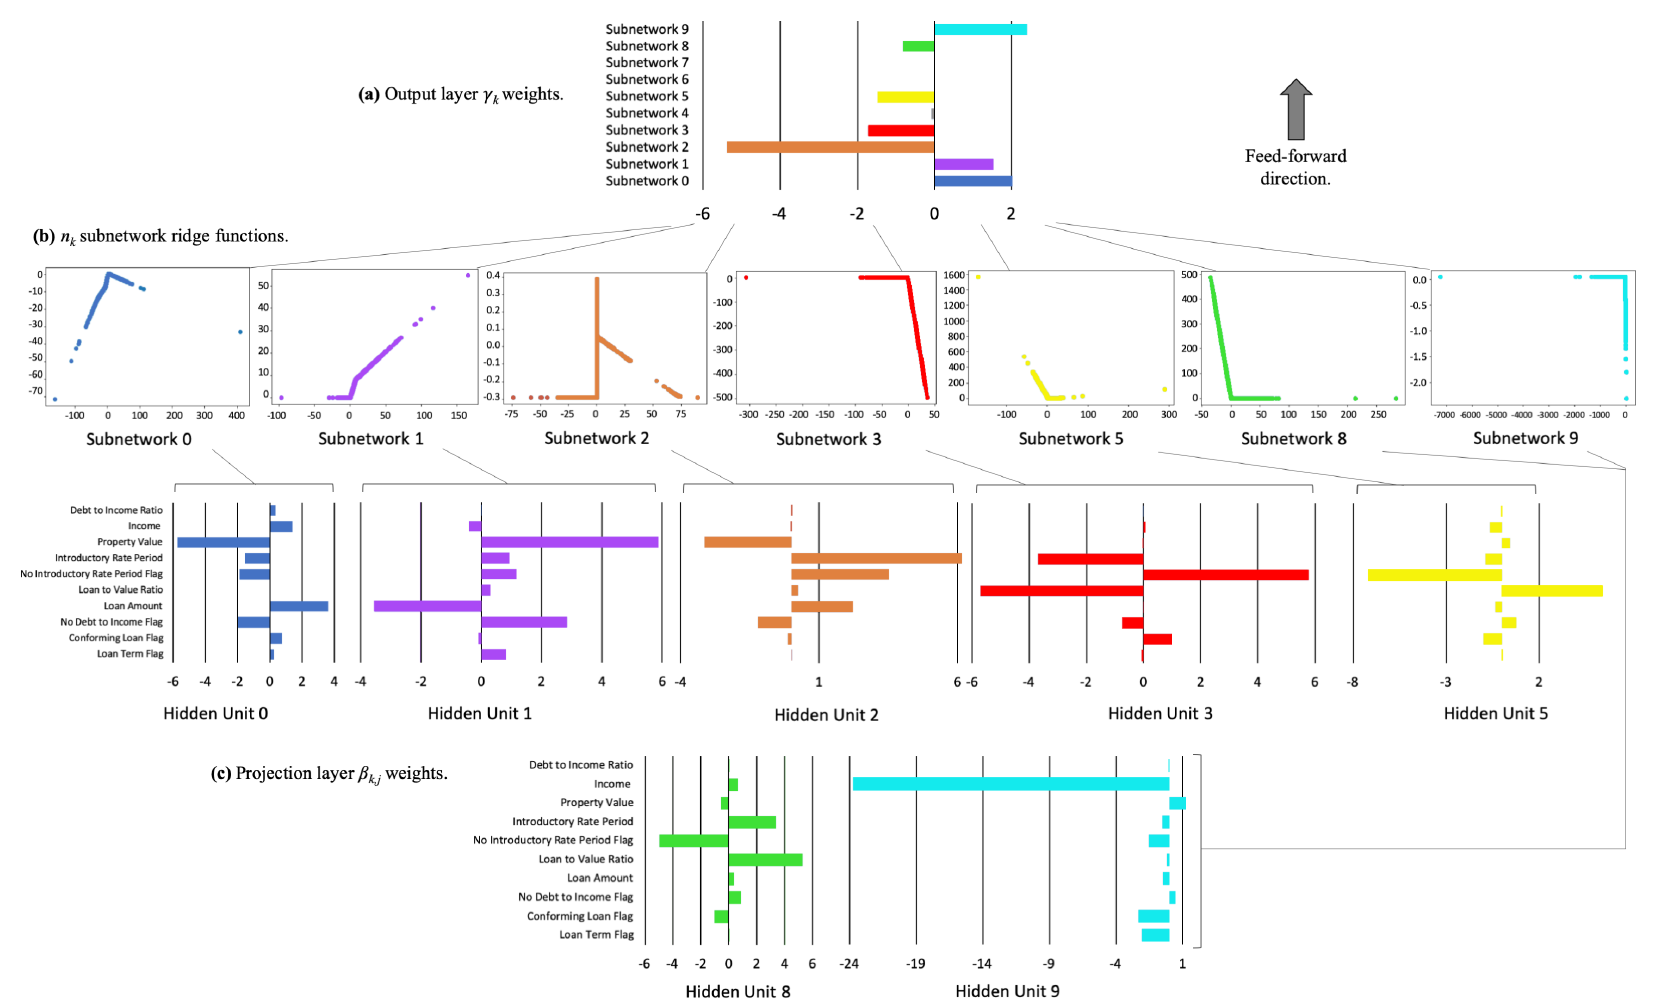
Figure 6. Output layer γ k weights, corresponding n k ridge functions, and associated projection layer β k , j weights for g XNN on the mortgage